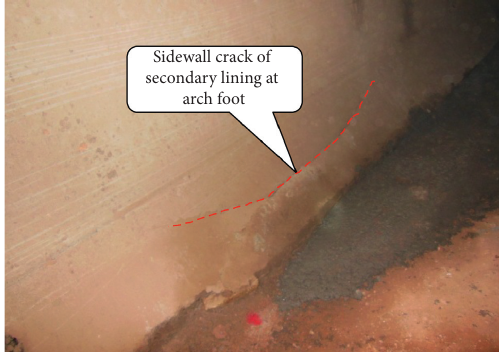
Figure 13: Crack of secondary lining at arch